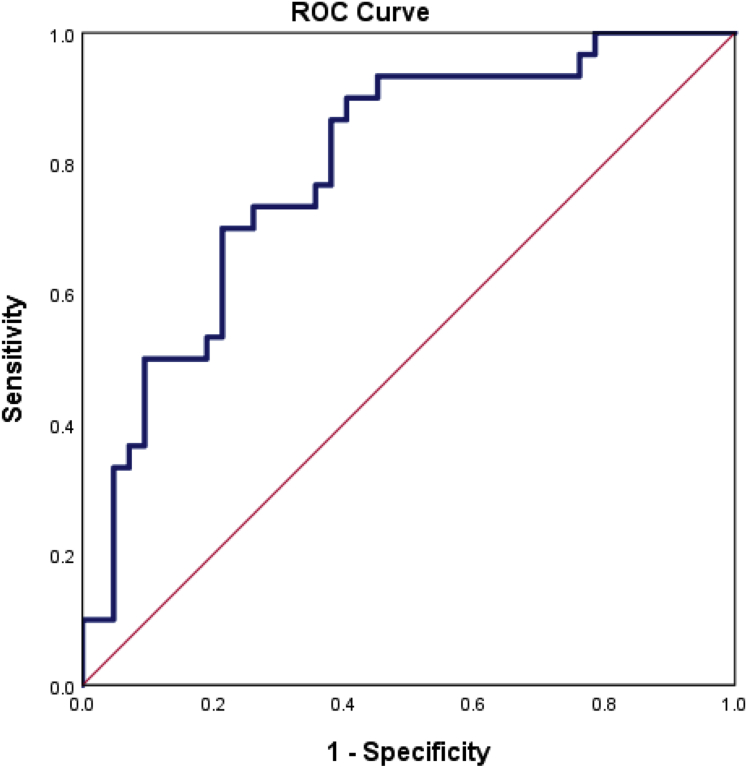
The area under the receiver operating characteristic curve (ROC) curve for the variable combining the percentage of fat, percentage of ballooning, and percentage of inflammation for diagnosing nonalcoholic steatohepatitis (nonalcoholic fatty liver disease activity score, ≥5).